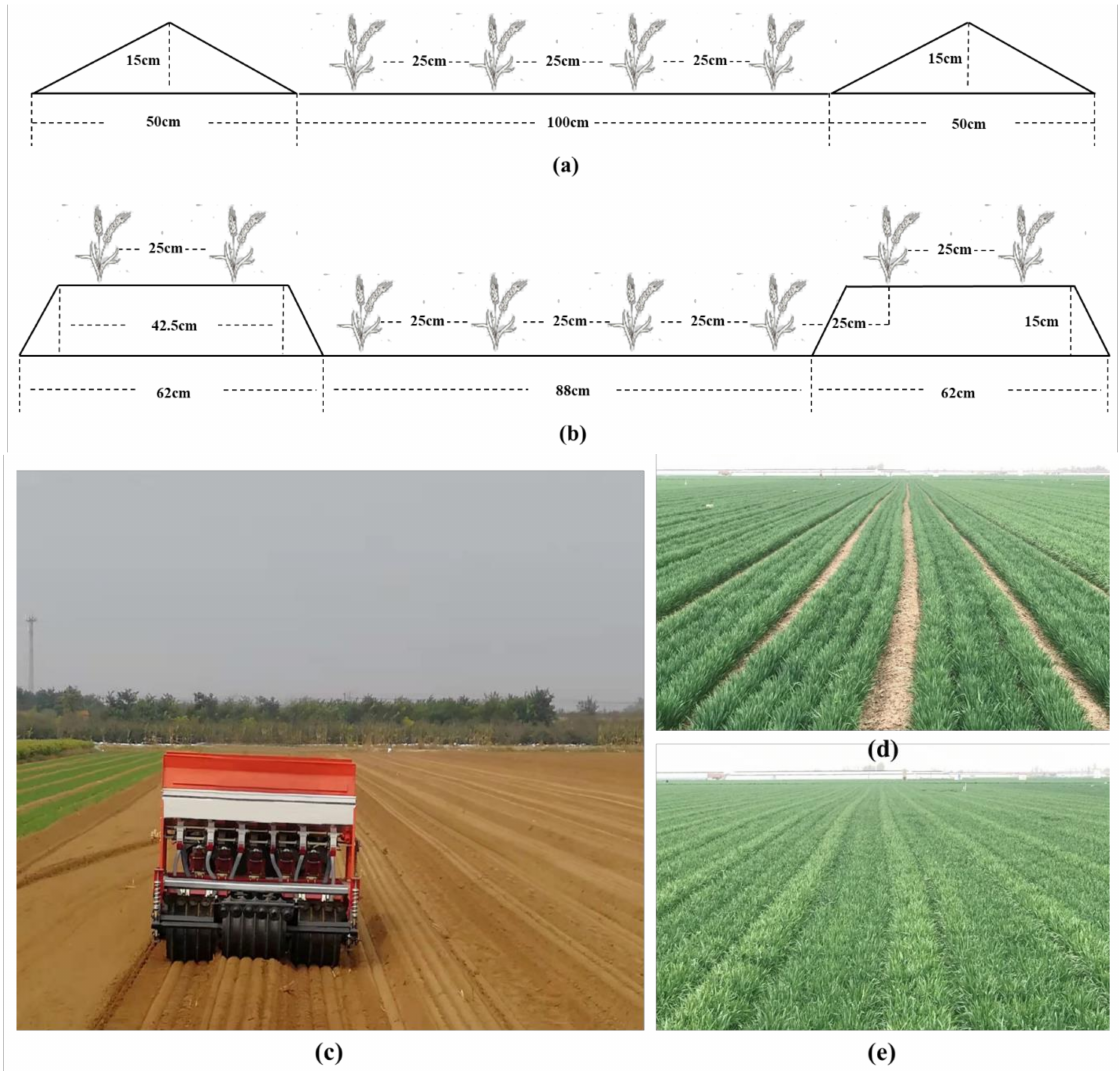
Figure 1. Sowing structures, sowing processes, and different field trials: ( a ) small-flat-plot mode; ( b ) high-low-plot mode; ( c ) sowing process by high-low border planter; ( d ) wheat plants grown in the small-flat-plot mode; ( e ) wheat plants grown in the high-low plot